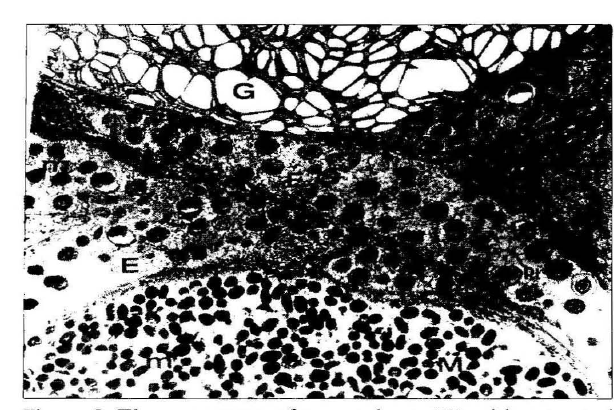
Figure 2. Electronogram of guano phore (G) with extracted guanine crystals in the cytoplasm; red pigment cells crythrophores (E) with cytoplasmic lamellar structllres, pterinosomes (Pt) and melanophore (M) with melanosomes (M) in the cytoplasm. One could see melanosome-like strucmres (m ) in the cytoplasm of eryhrophore~ (Hiuchi electron microscope,